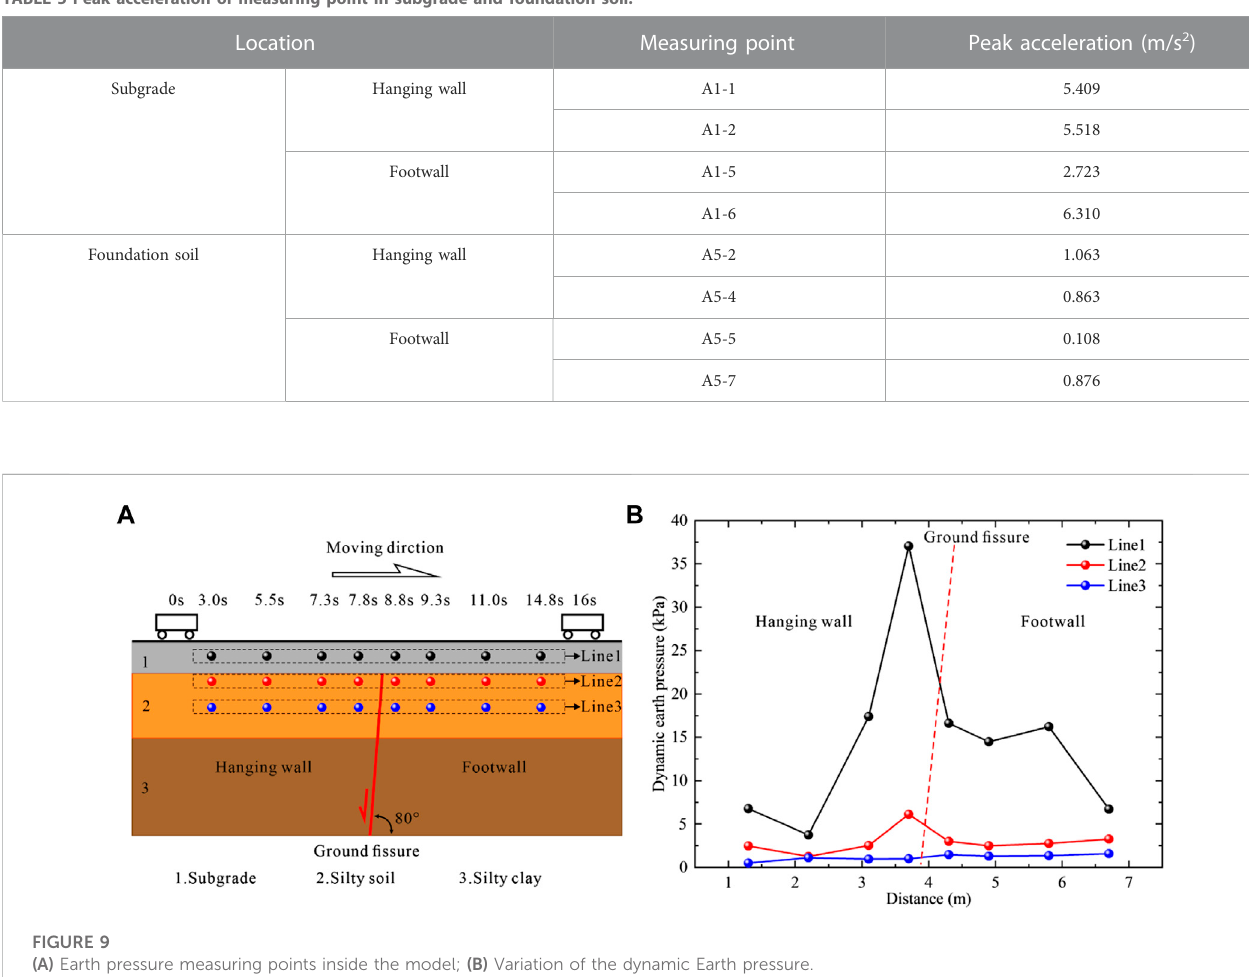
(Figure 7A). (P/A) means both earth pressure and acceleration are measured at this point. The displacement meter D1-1~D1-8 is arranged on the subgrade surface and ground surface (D2-1~D2-8) (Figures 7B, C). To facilitate analysis and discussion of the results, the measuring points were divided into 5 groups in the longitudinal direction, from up to down, as Line 1~Line 5. We then set two measuring lines along the horizontal direction: Line 6 in the hanging wall and Line 7 in the footwall.